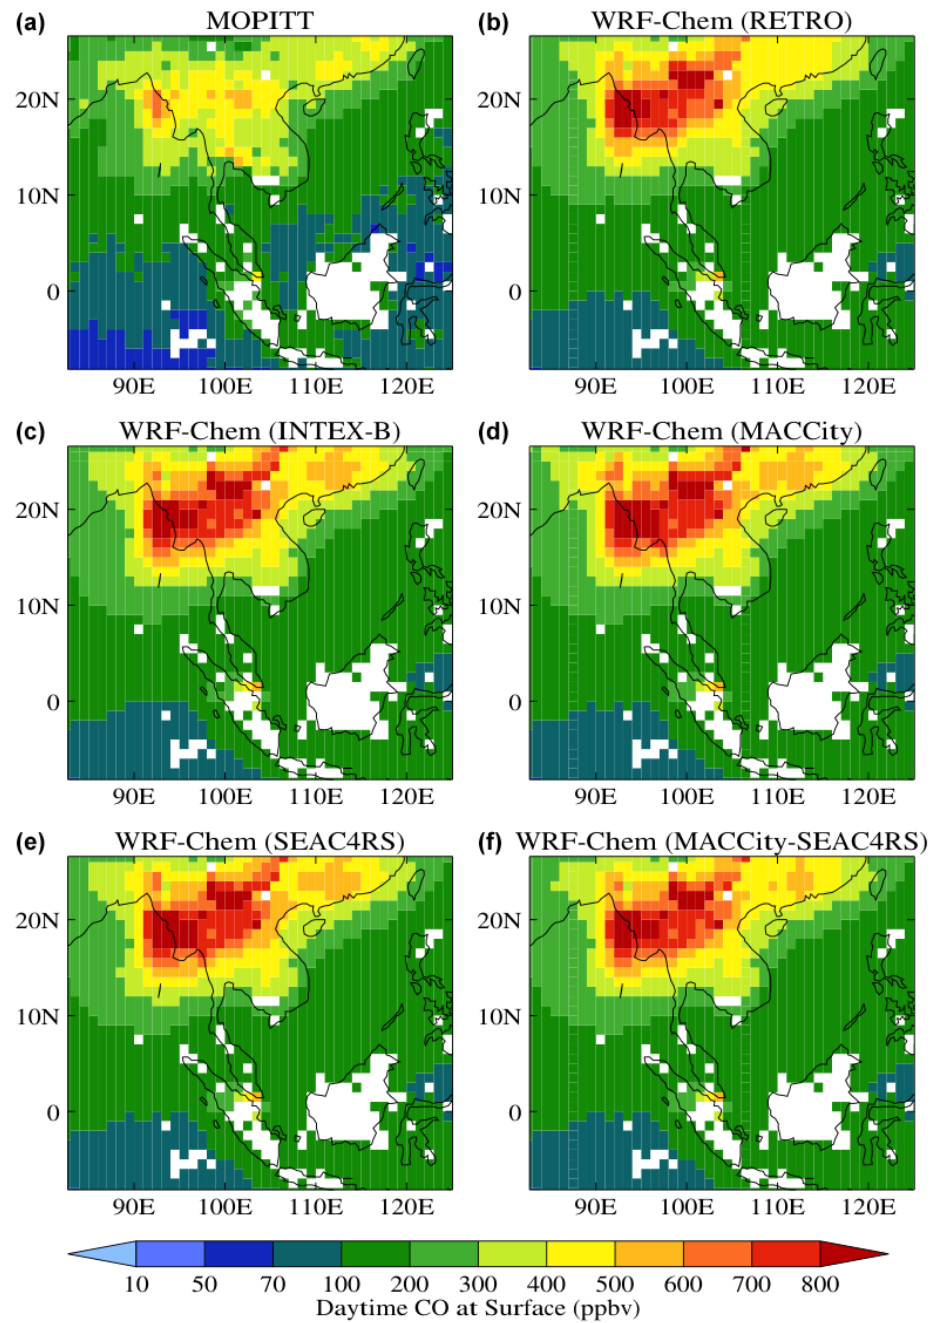
Figure 10. Carbon monoxide from WRF-Chem and MOPITT in March (a) MOPITT (b) WRF-Chem simulation with RETRO emission inventory, (c) WRF-Chem simulation with INTEX-B emission inventory, (d) WRF-Chem simulation with MACCity emission inventory, (e) WRF-Chem simulation with SEAC4RS emission inventory, (f) WRF-Chem simulation with MACCity–SEAC4RS emission inventory.